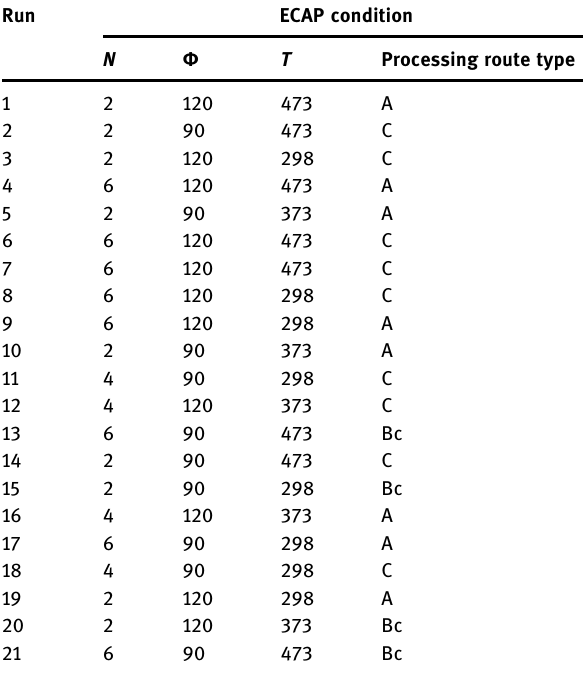
Table 2: Design of experiment of ECAP parameters